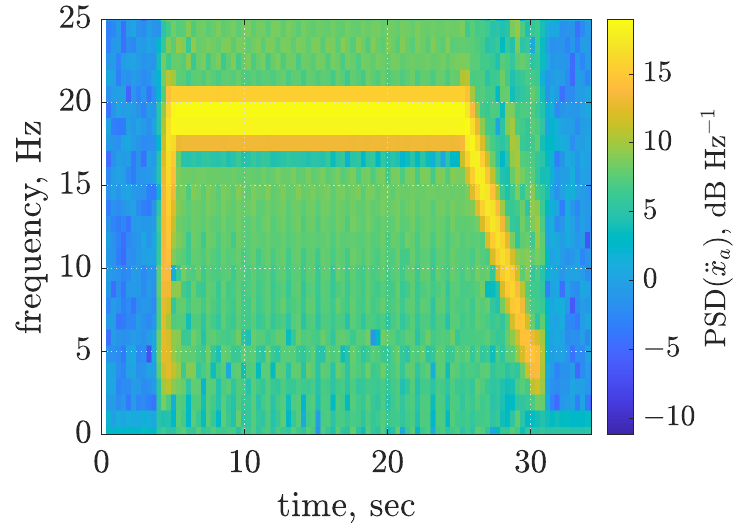
Figure 6. Time–frequency characteristics of the averaged horizontal acceleration of the screen riddle based on